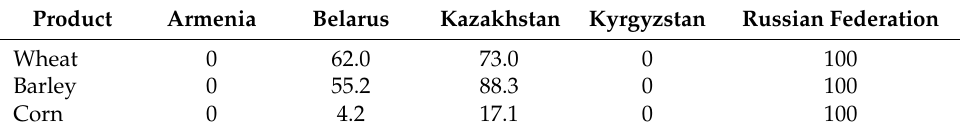
Table 1. Integral indicator of the competitiveness of grain in the EAEU countries in 2016, %. Product